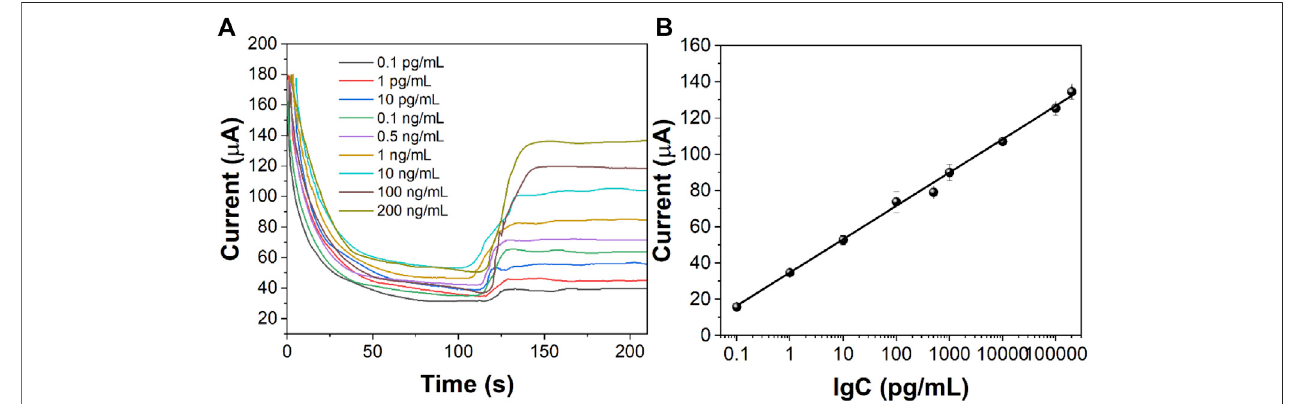
FIGURE 8 | (A) i-t curves of the immunosensor to different concentrations of CEA. (B) Calibration curve of CEA concentration against the value of the immunosensor.